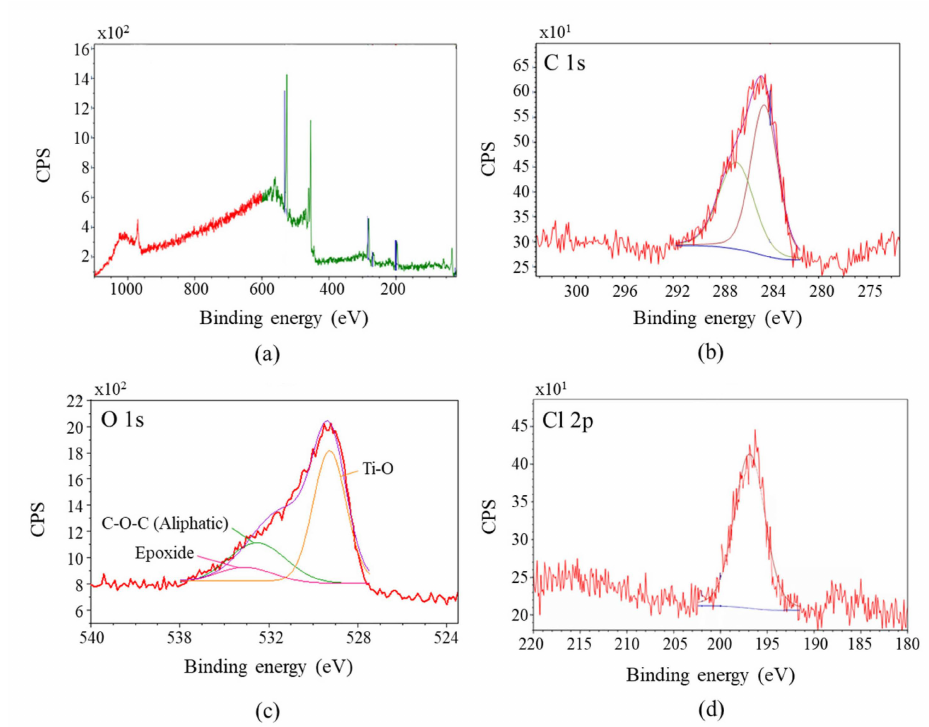
Figure 9. ( a ) The wide X-ray photoelectron spectroscopy (XPS) spectrum of ( b ) C1s ( c ) O1s, and ( d ) Cl2p for TEP24. CPS, cycles per